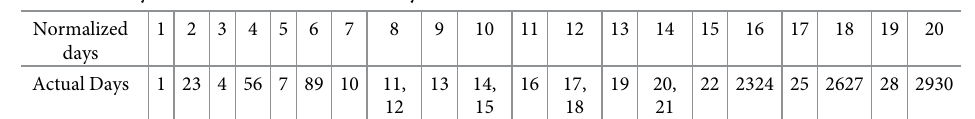
Table 4. 30 days duration normalize into 20